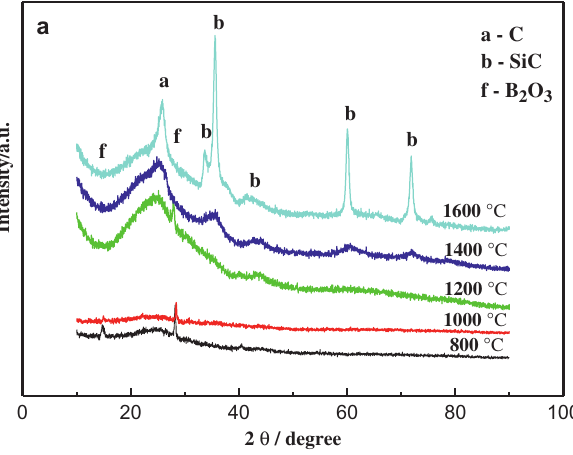
Figure 1: XRD patterns of the B-Si-doped carbon materials obtained by carbonization treatment at different temperatures for 1